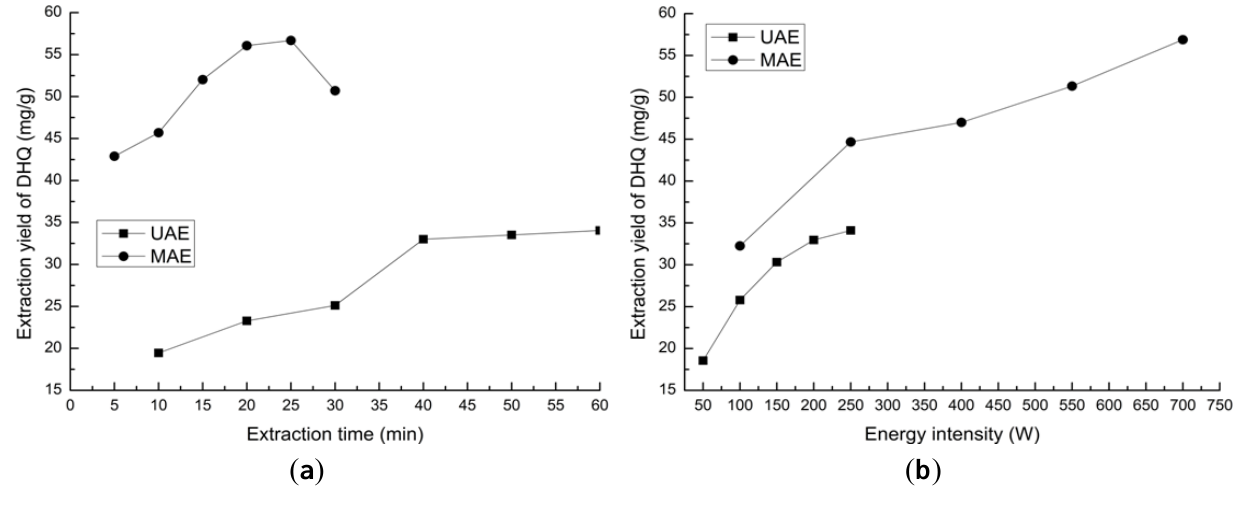
Figure 2. Effect of core factors on extraction yield of DHQ. ( a ) Effect of extraction time on extraction yield; ( b ) Effect of energy intensity on extraction